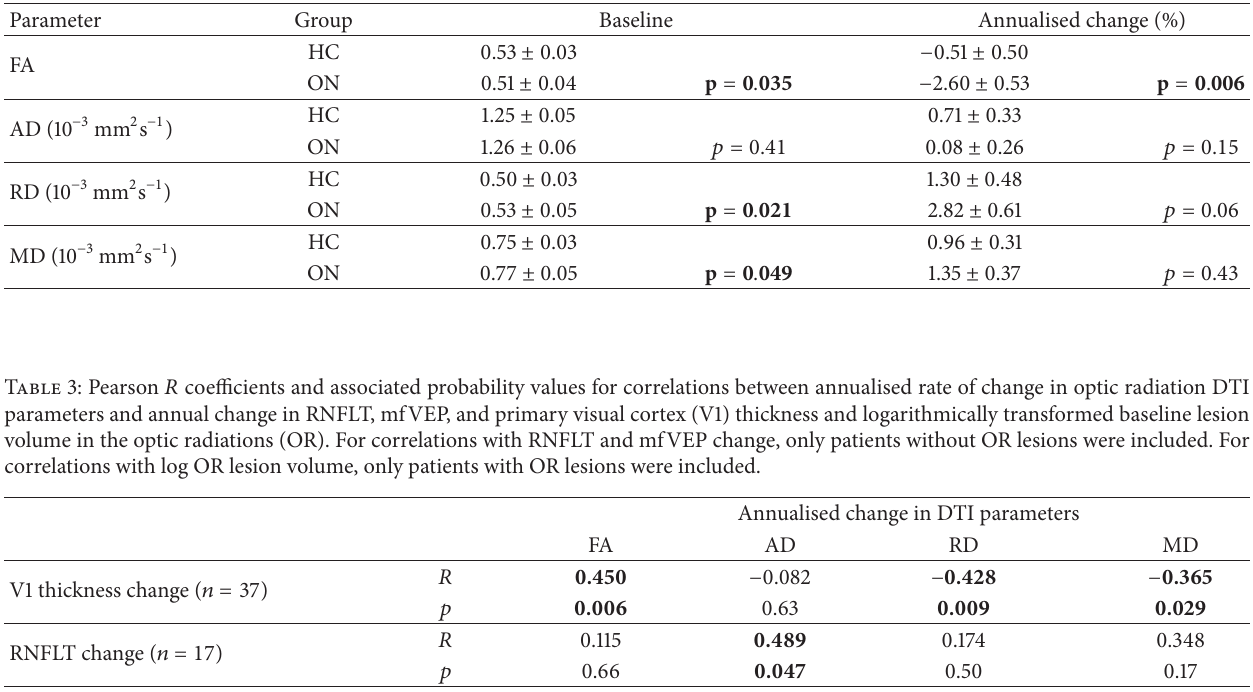
Table 2: Average ( ± SD) baseline and annualised change in optic radiation fractional anisotropy (FA), axial diffusivity (AD), radial diffusivity (RD), and mean diffusivity (MD) for healthy controls (HC) and optic neuritis (ON) groups.